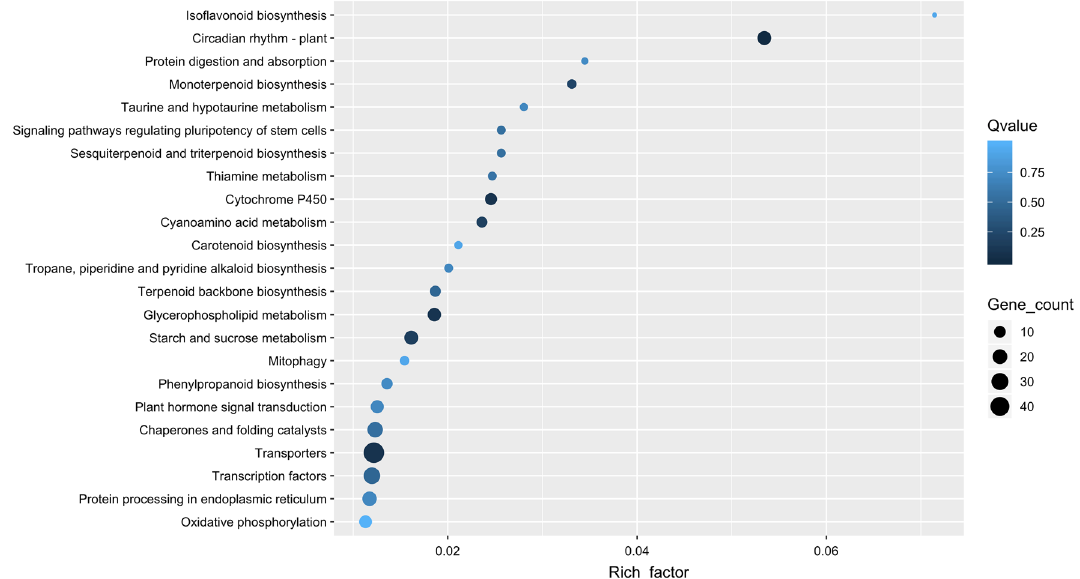
Figure 4. Scatter plot-enriched Kyoto Encyclopedia of Genes and Genomes (KEGG) pathways of differentially expressed genes (DEGs) in drought stressed plants compared to control plants in the field. The x-axis represents the gene ratio, which refers to the ratio of the DEG numbers annotated in the pathway term to all gene numbers annotated in the pathway term. The circle size indicates the number of DEGs that are associated with each significant pathway. The circle color indicates the significant level with the adjusted p-value using Benjamin Hochberg